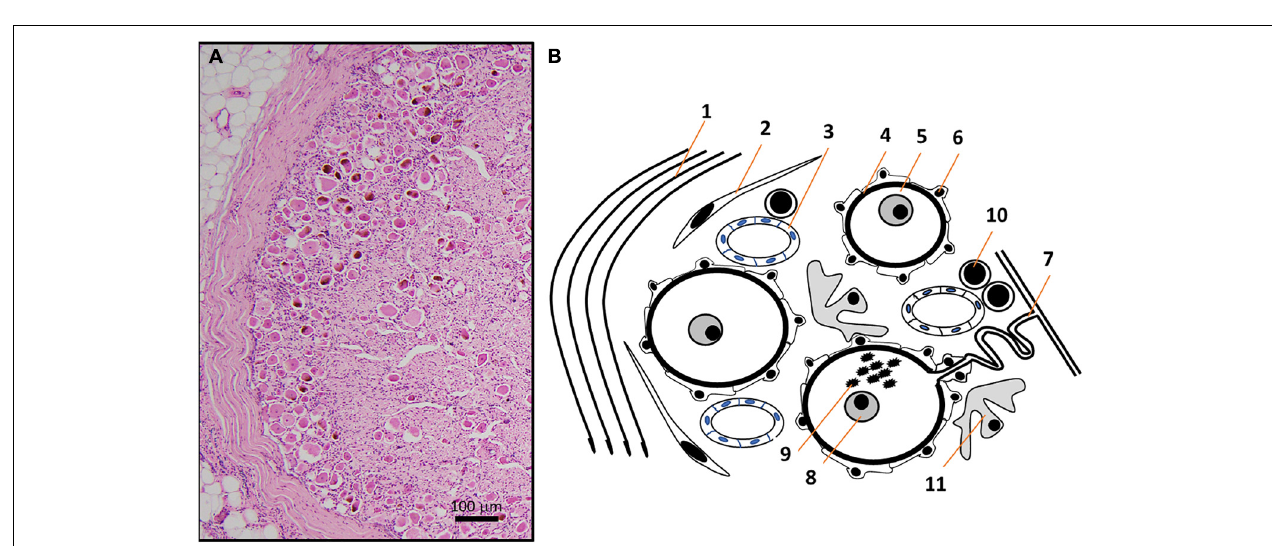
FIGURE 2 | (A) HE micrograph section of a thoracic human DRG in higher magnification shows a high number of neuronal somata of different sizes in the periphery of DRG, next to the thick connective tissue covering. (B) Schematic representation of the HE micrograph figure highlighting the variety of different structures and cell types in human DRG. Connective tissue layers (Reina et al., 1996) (1), fibroblasts (2), capillaries (Kutcher et al., 2004) (3), basement membrane (Johnson, 1983) (4) between nerve cells (5) and satellite cells (Hanani, 2005) (6). The pseudo-unipolar process (Rudomin, 2002) (7) originates from sensory neurons with prominent